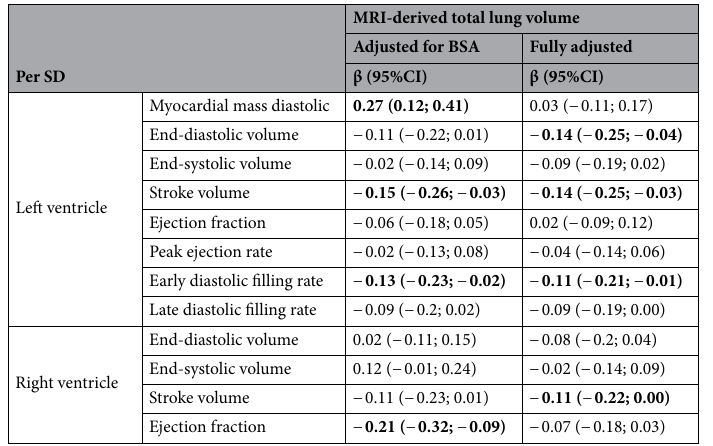
Table 3. Relation between cardiac measurements and MRI-derived total lung volume. The beta estimate given with a 95% confidence interval represents the association size between cardiac measurements and MRI derived total lung volume. The fully-adjusted model includes the following covariates: age, sex, BSA, and smoking status. BSA body surface area. Bold font indicates statistical significance (P <